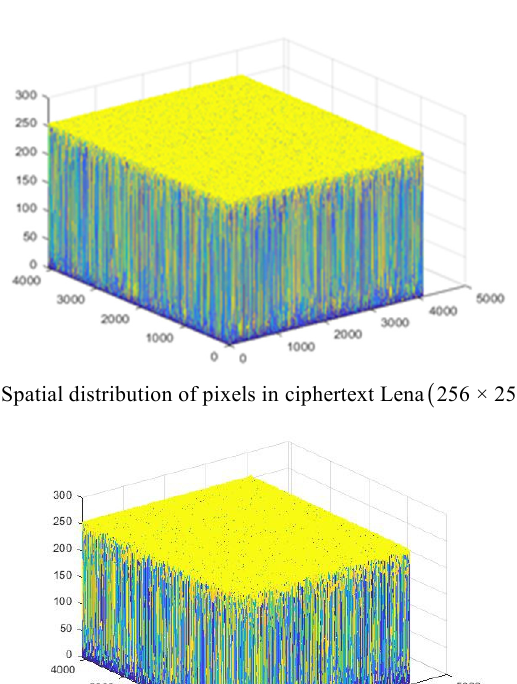
Figure 11. Histogram of 128 × 128 plaintext in 2D.